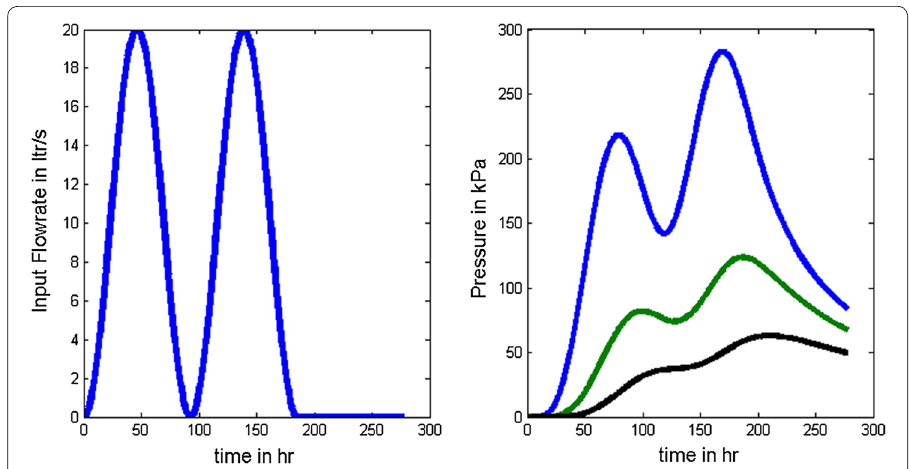
Fig. 2 Pressure response to two injection cycles in a homogeneous isotropic reservoir with a diffusivity of 0.1 m 2 /s at 200 m (blue), 300 m (green), and 400 m (black) distance to the injection point (Wenzel